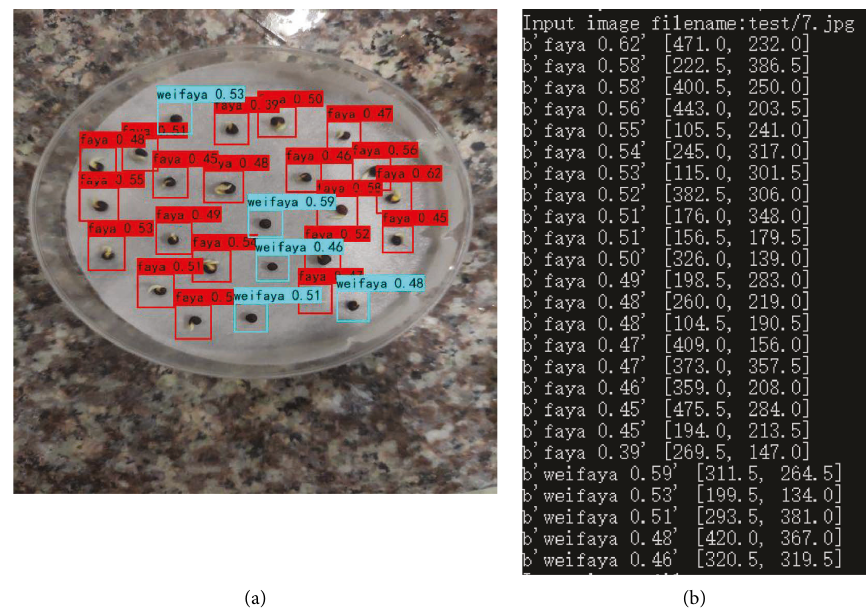
Figure 9: Model test results after changing the loss function. (a) Identified targets. (b) Score and center position (score improved significantly).